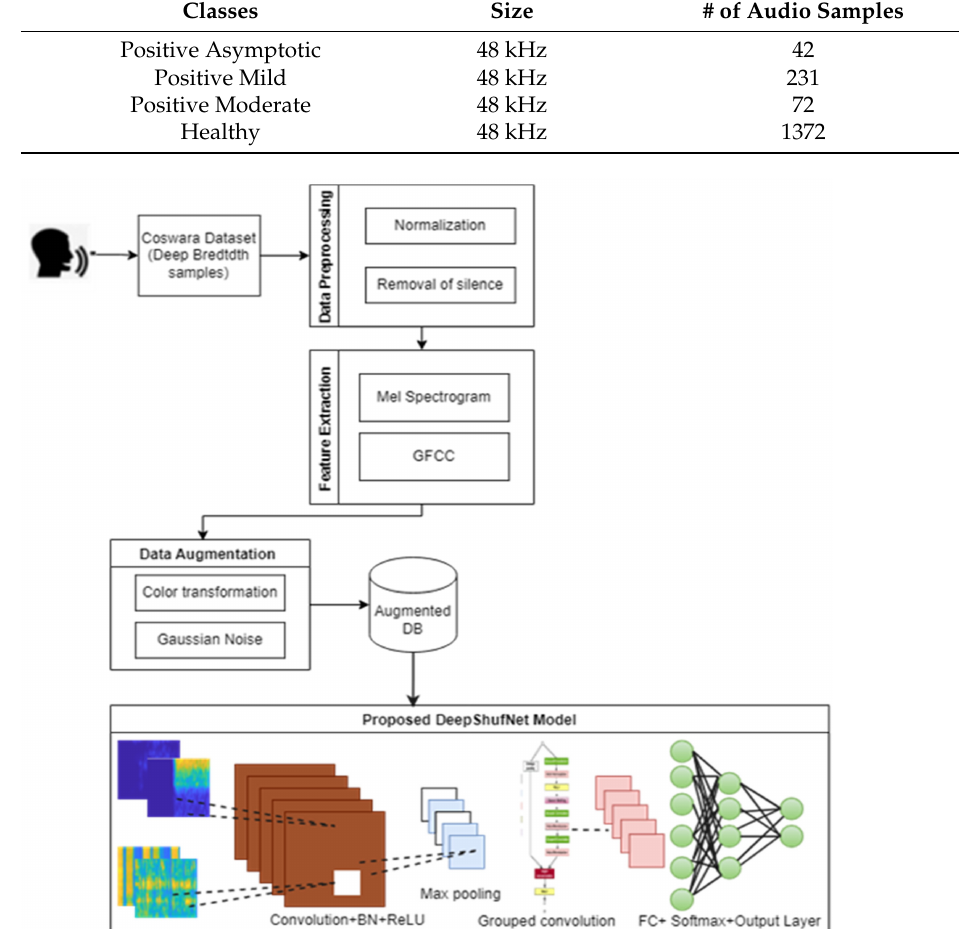
Figure 2. Proposed Architectural